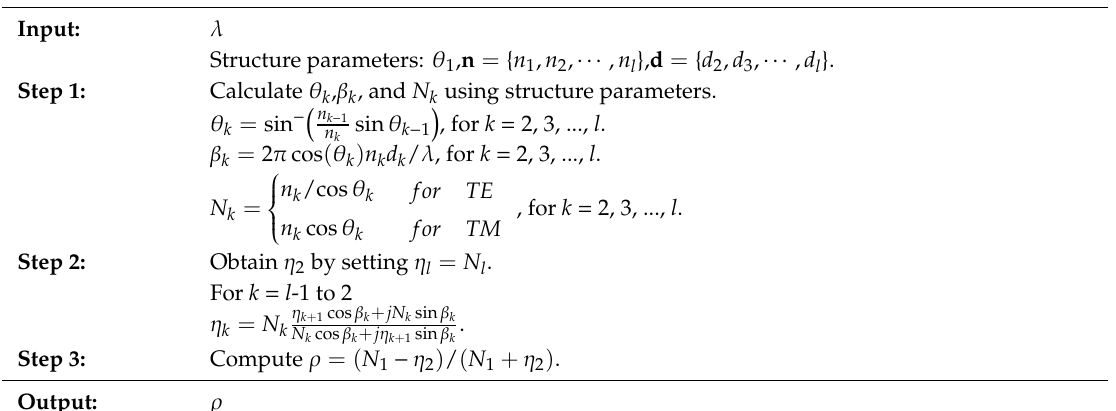
Algorithm 1: Recursive processes for amplitude reflection coe ffi